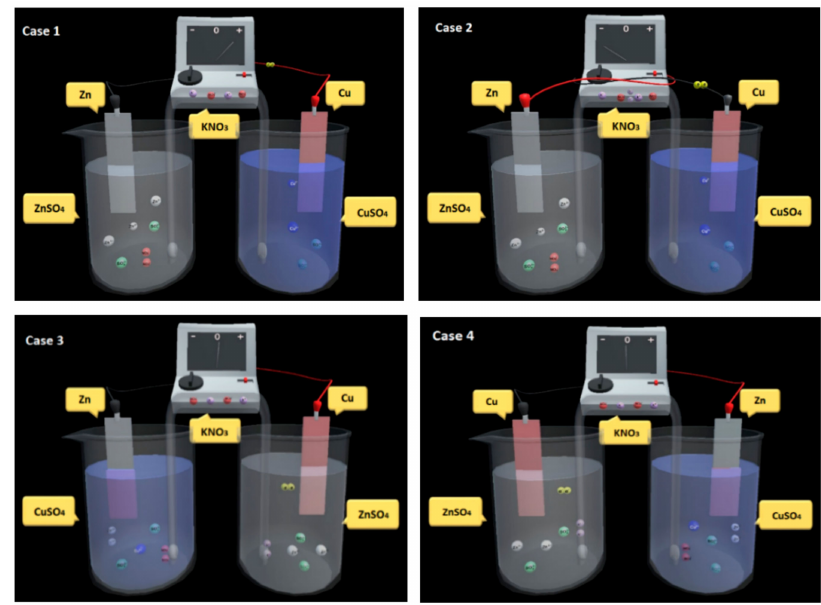
Figure 10. Trying different materials and connections of